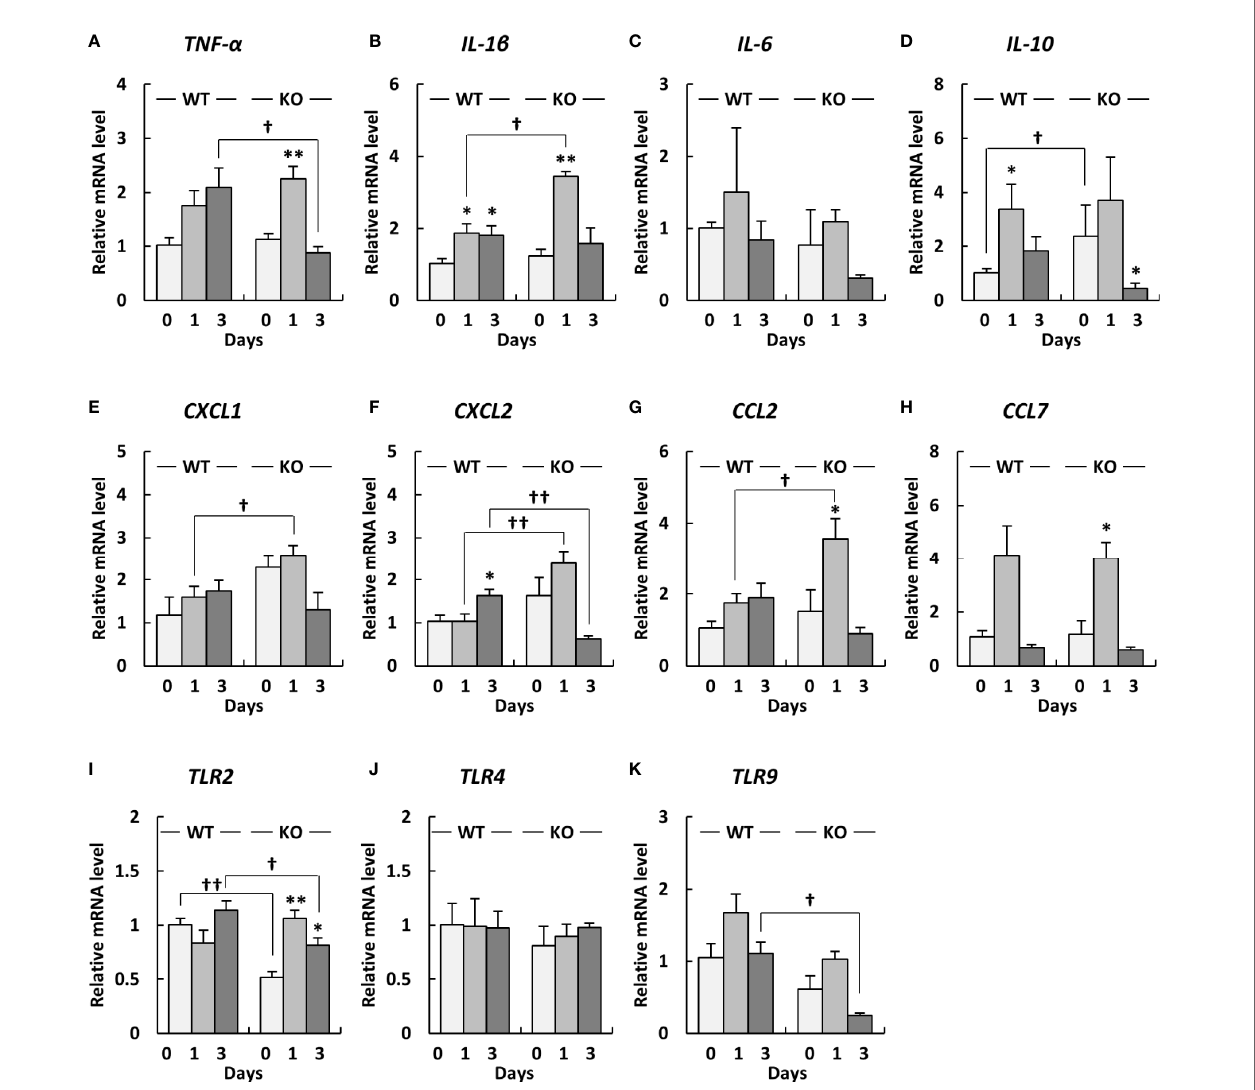
FIGURE 4 | Proin fl ammatory cytokine expression levels in the lungs and Toll-like receptor ( TLR) 2/4/9 gene expression levels in the lungs of klotho wildtype (WT) and knockout (KO) mice before and after infection with Acinetobacter baumannii . The mRNA levels of (A) TNF- a , (B) IL-1 b , (C) , IL-6 (D) IL-10 , (E) CXCL1 , (F) CXCL2 , (G) CCL2 , (H) CCL7 , (I) TLR2 , (J) TLR4 , and (K) TLR9 in the lungs of klotho WT and KO mice before and after infection with A. baumannii . Bar graph data represent the mean ± SEM and were compiled from four independent experiments ( n = 12 for WT and n = 12 for KO mice). Asterisks indicate statistically signi fi cant differences (** P < 0.01; * P < 0.05, before infection vs. after infection, Student ’ s t -test; †† P < 0.01; † P < 0.05, klotho WT mice vs. klotho KO mice, Student ’ s t